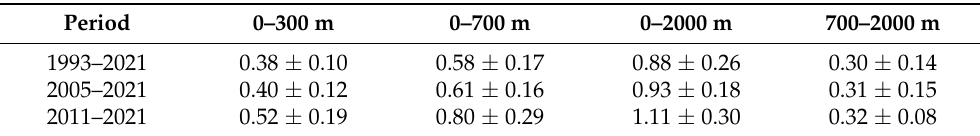
Table 2. Global OHC trends derived from the ensemble mean for the four datasets (OPEN, IAP, EN4, and Ishii datasets) for different periods and different depth layers (unit: W m − 2 ). The uncertainty range of the global OHC trends is given at a 95% confidence